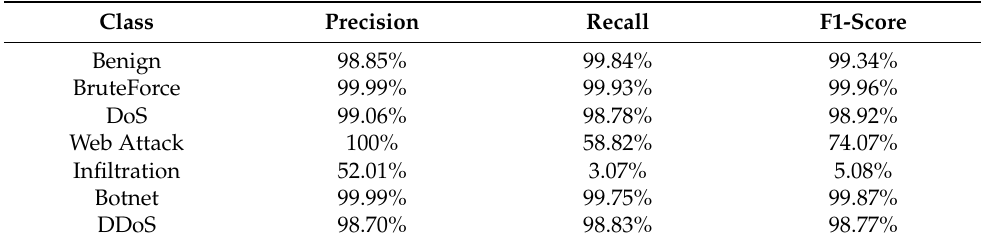
Table 26. CNN + LSTM evaluation results for multi-class classification.